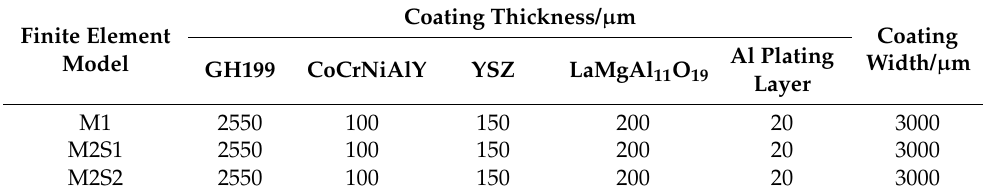
Figure 2. Two-dimensional finite element physical model: ( a ) M1, ( b ) M2S1, ( c ) M2S2. Table 3. Thickness and width of each layer in the finite element model. Coating Thickness/ µ m Finite Element Model